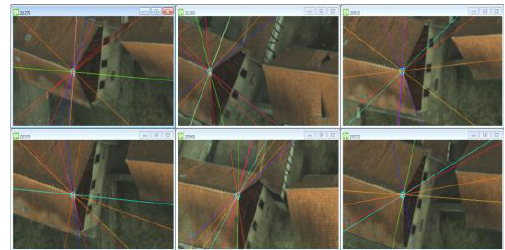
Figure 9. Distribution of the six test measurements